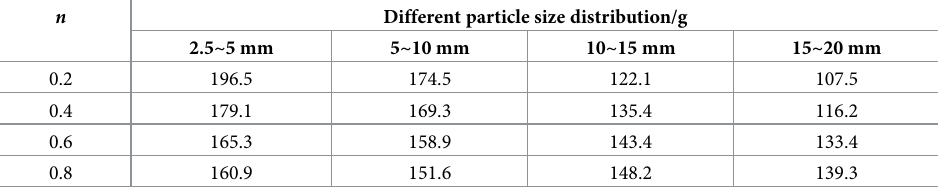
Table 1. Sample mass